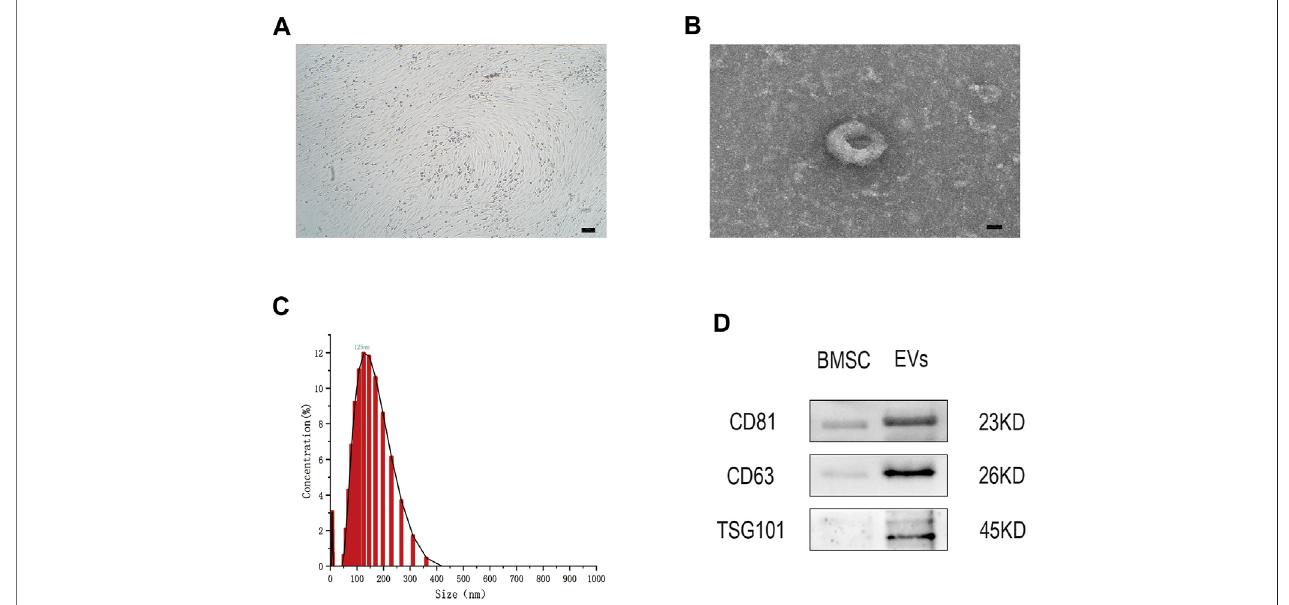
FIGURE 1 | (A) The hMSCs were observed by optical microscope. Scale bar (cid:2) 100 μ m. (B) The cup-shaped EVs under TEM. Scale bar (cid:2) 25 nm (C) Size and concentration of EVs analyzed by NTA. (D) The indicated protein (CD9, CD63, and TSG101) in EVs were detected via western blotting. n (cid:2) 3.